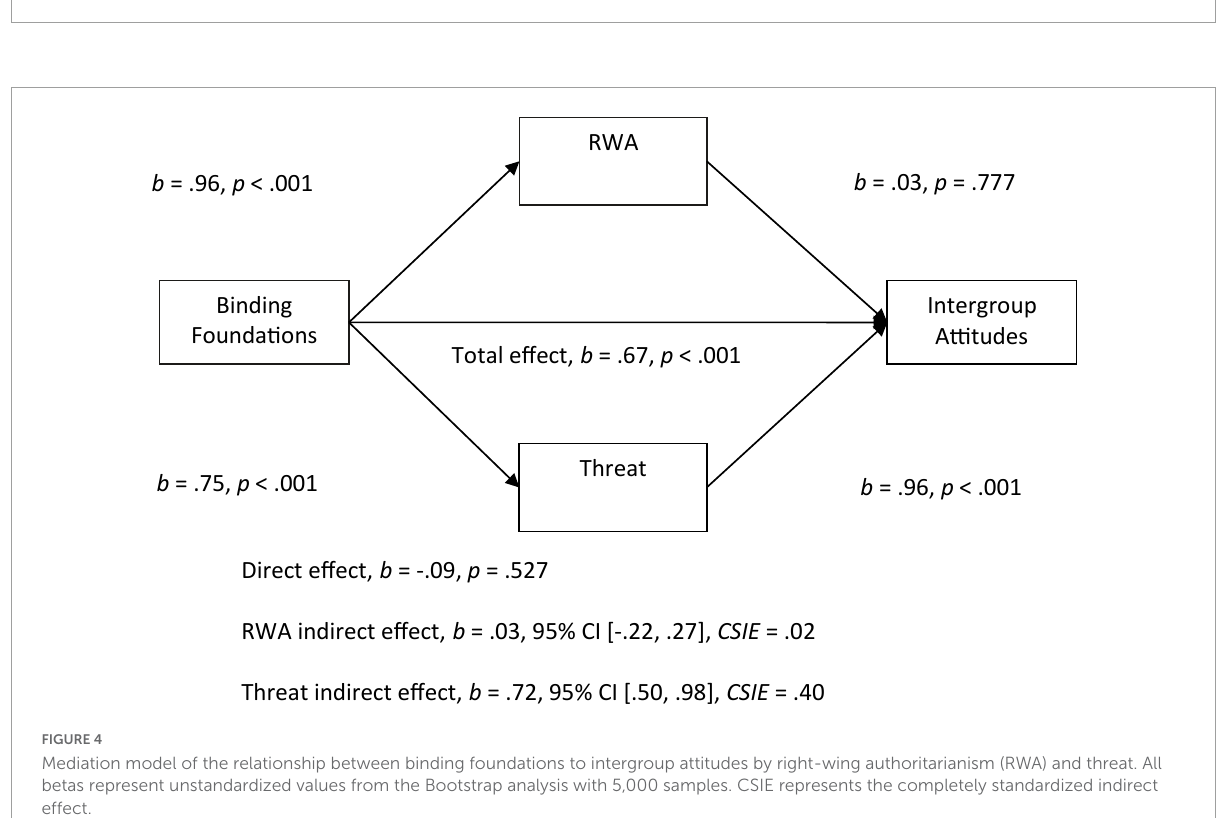
FIGURE3 Mediation model of the relationship between individualizing foundations to intergroup attitudes by social dominance orientation and threat. All betas represent unstandardized values from the Bootstrap analysis with 5,000 samples. CSIE represents the completely standardized indirect effect.